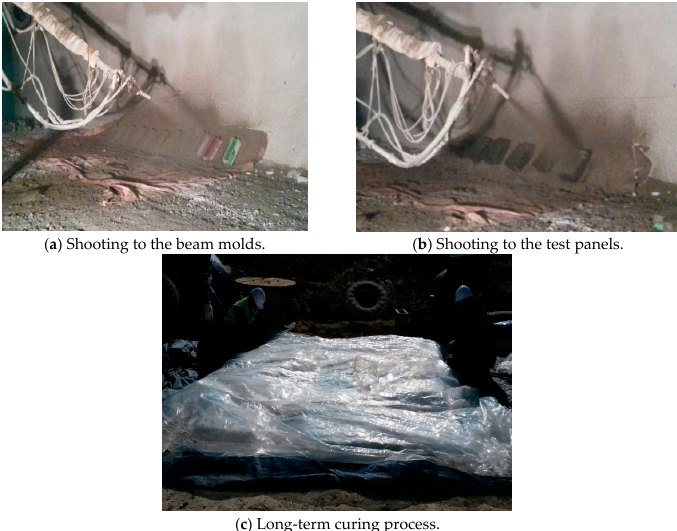
Figure 2. Sample casting and perpetration.